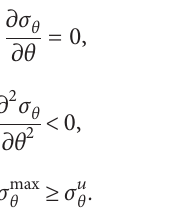
Figure 7: Maximum tangential stress and minimum and maximum shear stress versus confining pressure coefficient. (a) λ (b) λ θ < λ rθ